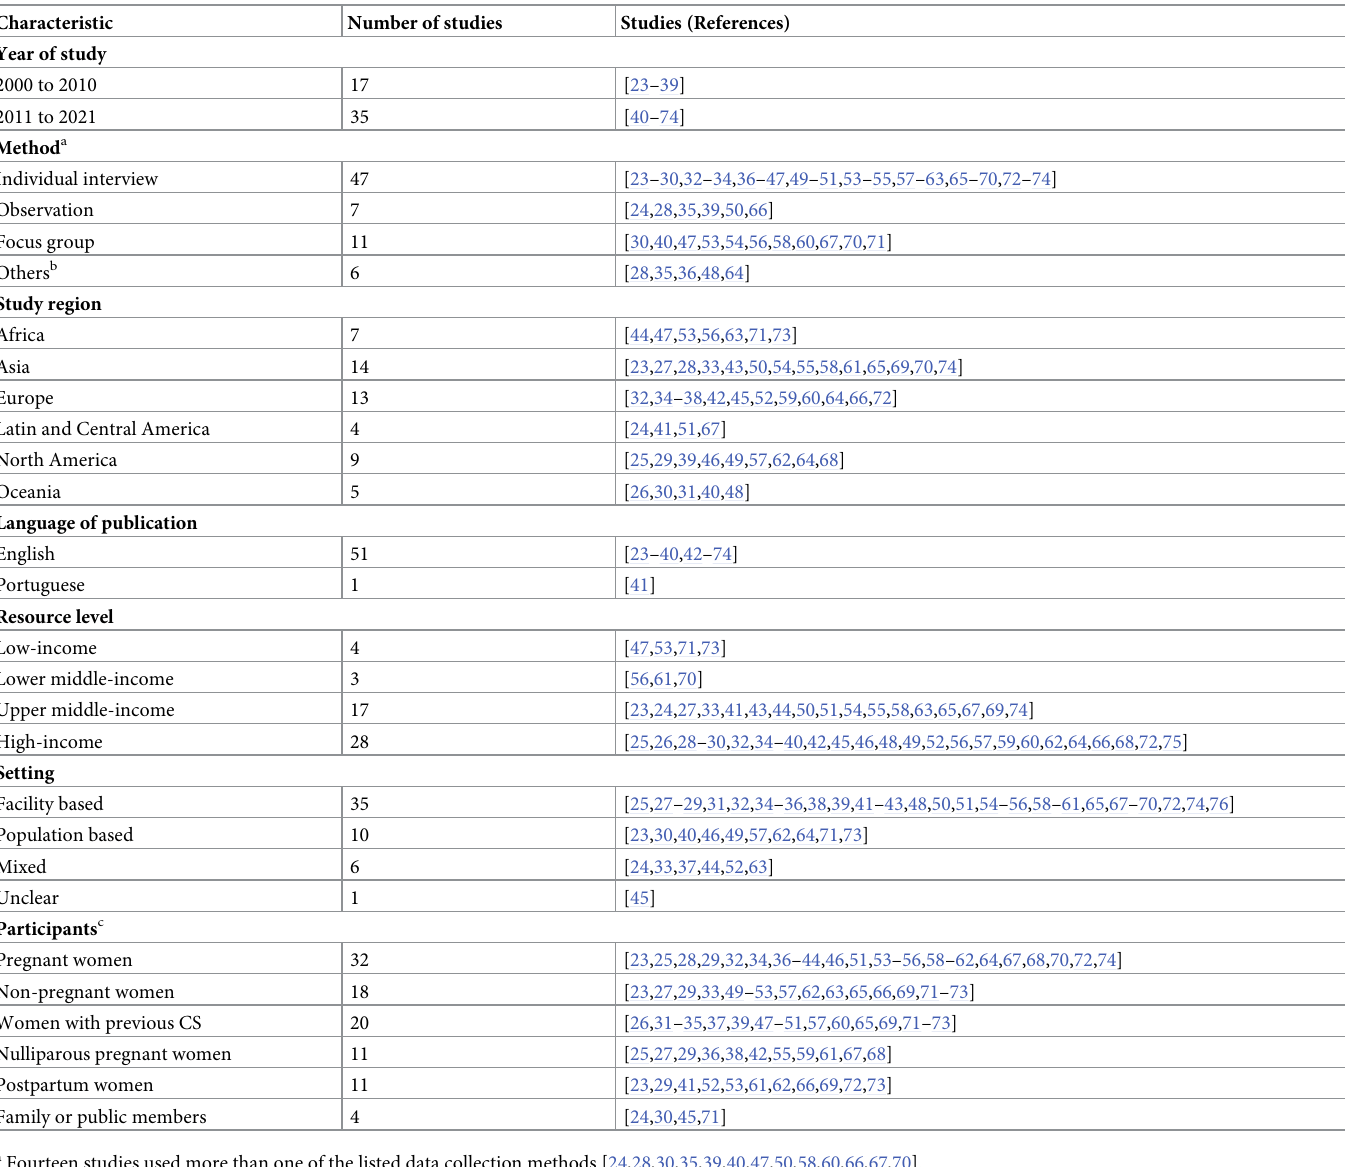
Table 2. Summary of characteristics of included